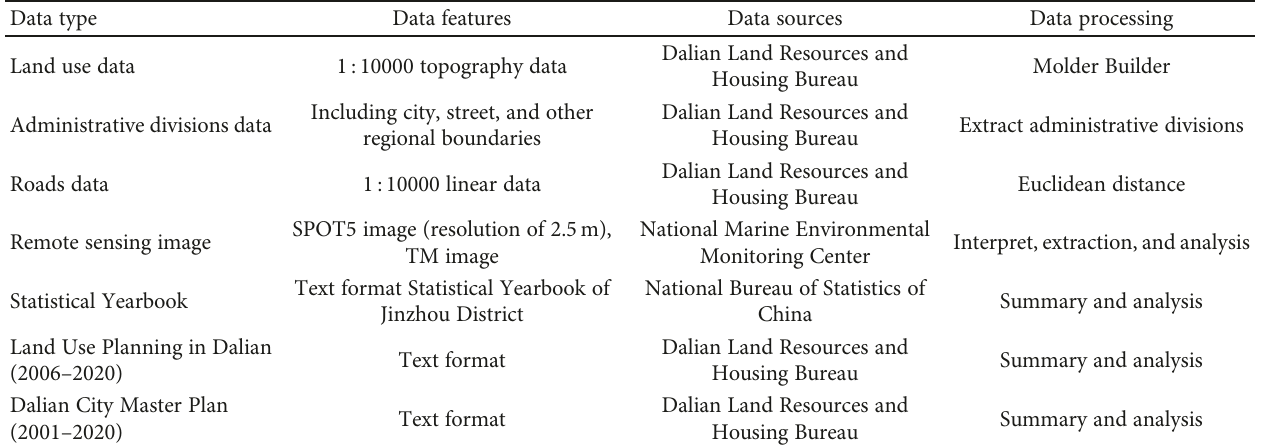
Table 2: Data sources and